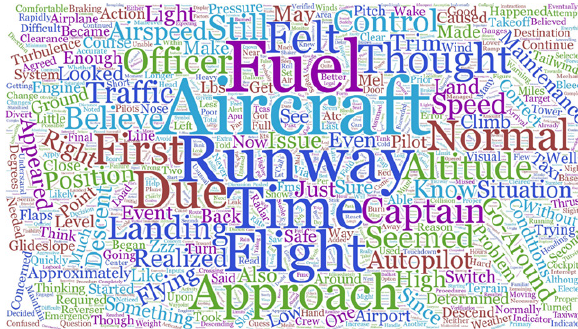
Figure 2. Word cloud of narrative elements coded as attention Figure 3. Word cloud of narrative elements coded as perception